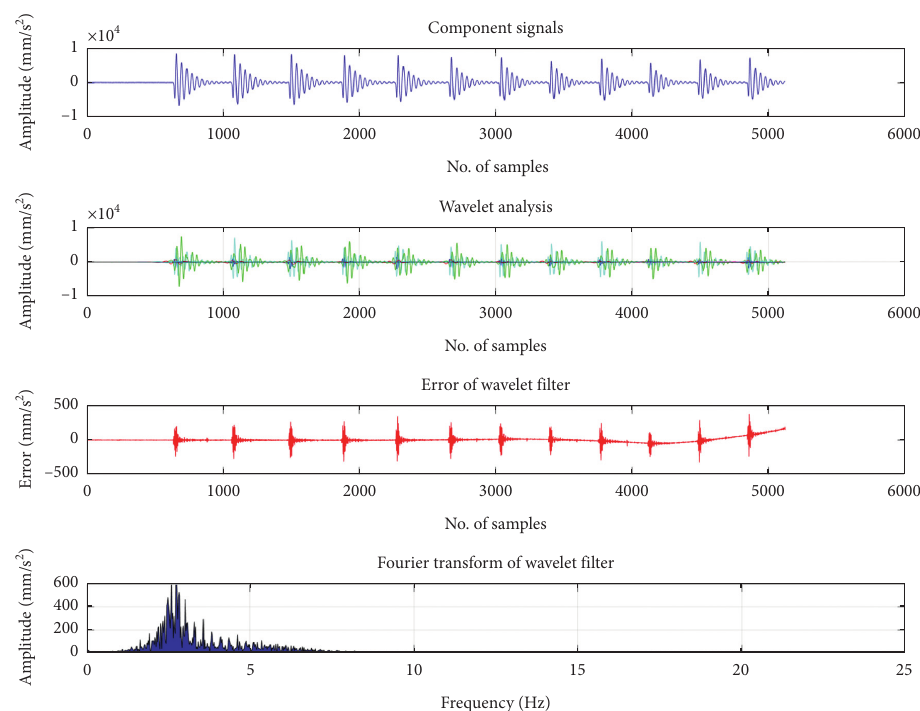
Figure 10: Signal of vehicle model carrying out multiple vibrations on the structure in case